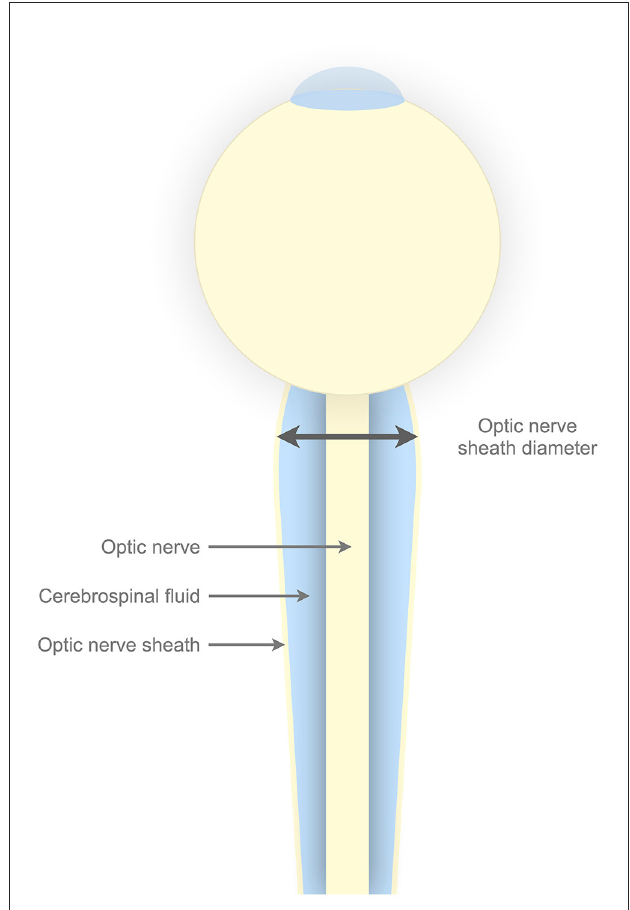
FIGURE1 Illustrative figure of the optic nerve sheath complex. The optic nerve sheath envelopes the cerebrospinal fluid. The cerebrospinal fluid surrounding the optic nerve is in direct communication with intracranial cerebrospinal fluid. Horisontal line with arrows in both ends illustrates the optic nerve sheath diameter, which by convention is measured 3mm posterior to the lamina cribrosa.